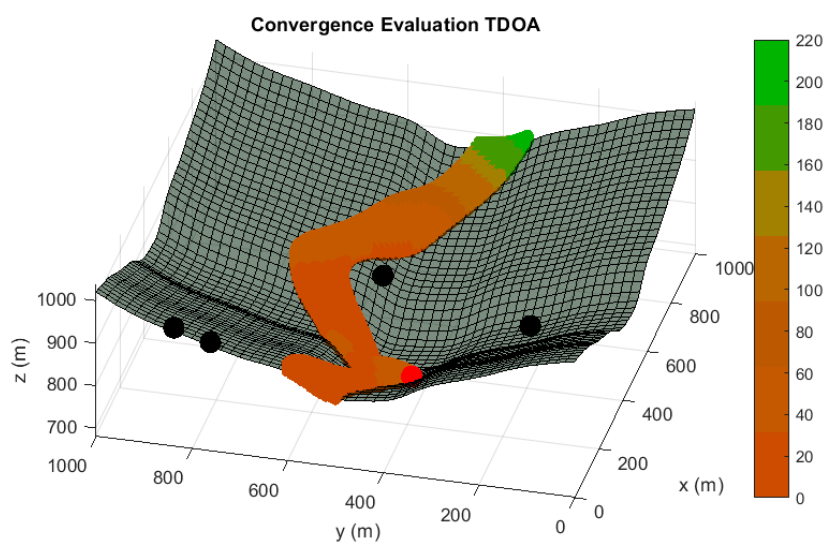
Figure 4. Convergence radius analysis in meters for a random sensor distribution of 5 sensors, under the assumption of one randomly malfunction sensor. The convergence radius represents the maximum radius of the sphere of convergence in which every inside point used as initial iterating point of the positioning algorithm guarantees the unequivocal position determination by using the four available sensors. It represents the same operating condition than Figure 2. Red tones in the color bar indicate bad convergence radius values, while green tones imply acceptable convergence magnitudes.